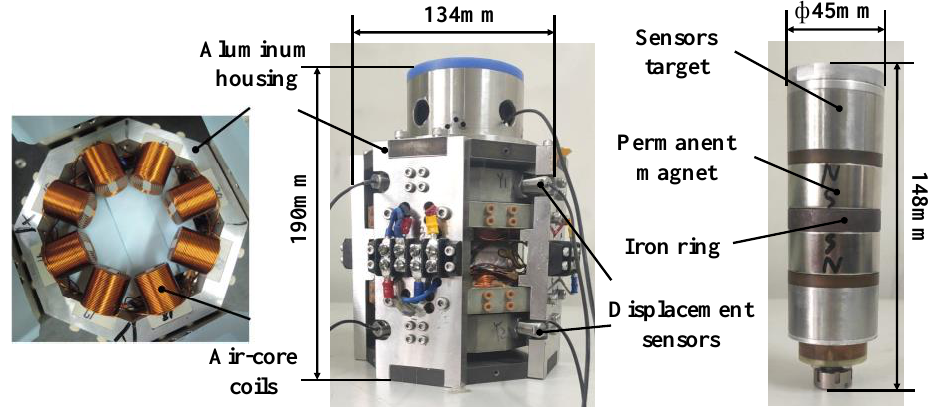
Figure 3. Experimental magnetic levitation actuator and its spindle.